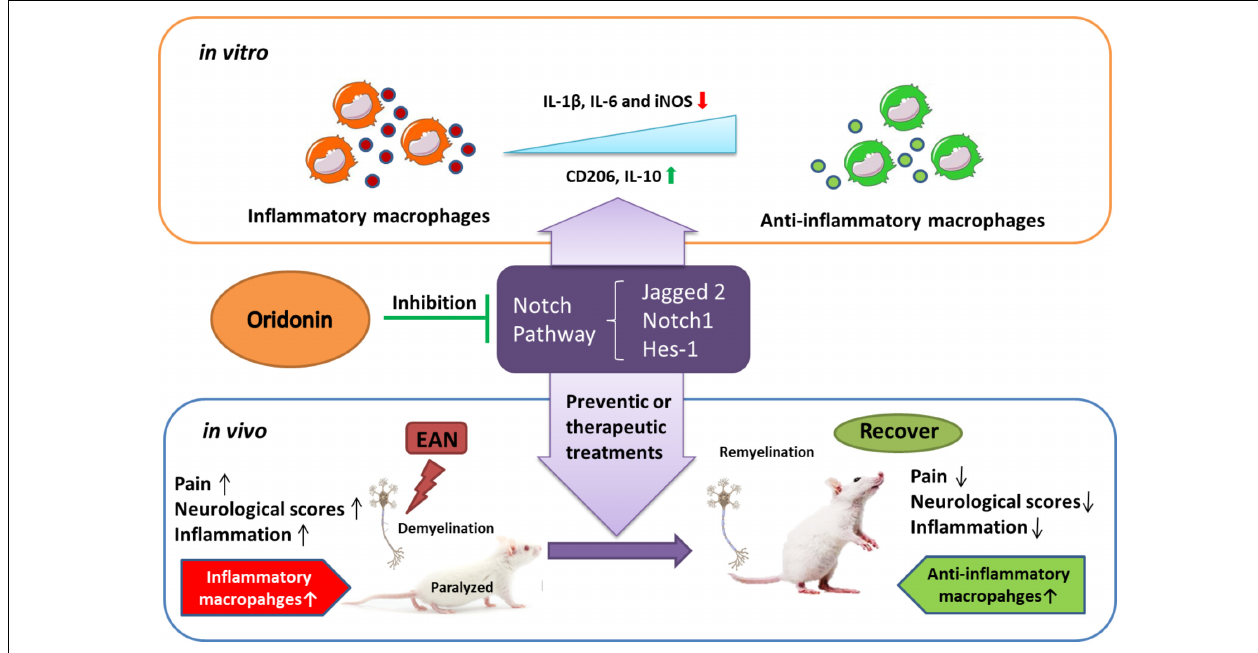
FIGURE 6 | Schematic diagram showing how Oridonin ameliorates experimental autoimmune neuritis by promoting anti-inflammatory macrophages through blocking Notch pathway. Oridonin exhibits efficient anti-inflammatory activity and induced a switch in macrophage polarization to the anti-inflammatory phenotype through inhibition of the Notch pathway in our in vitro study. Further in the EAN rats, Oridonin significantly reduced neuropathic pain, demyelination, inflammatory cellular accumulations and inflammatory cytokines in peripheral nerves, effectively suppressed disease progression by attenuating local inflammatory reaction and increasing the proportion of immune regulating macrophages, possibly through blockage of the Notch